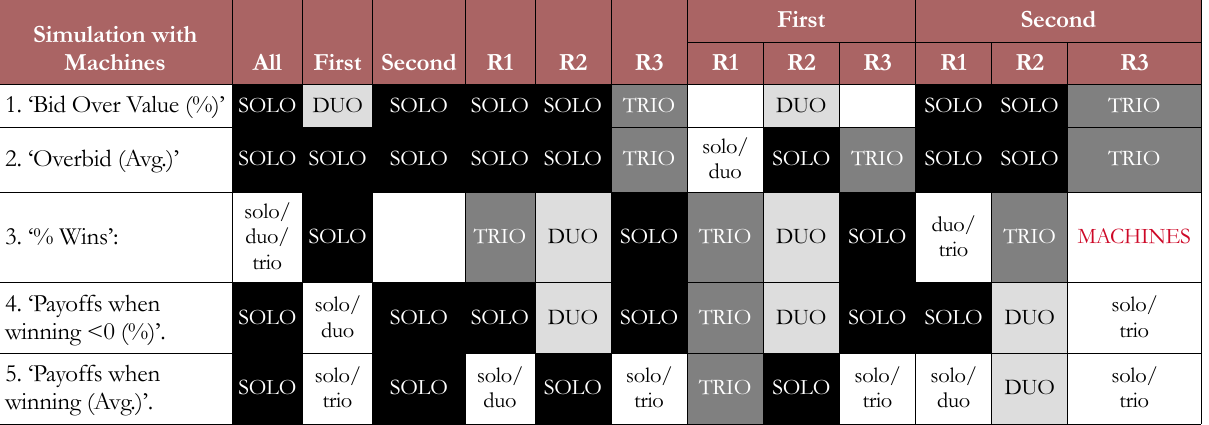
Table 11. Summary of comparisons including rational